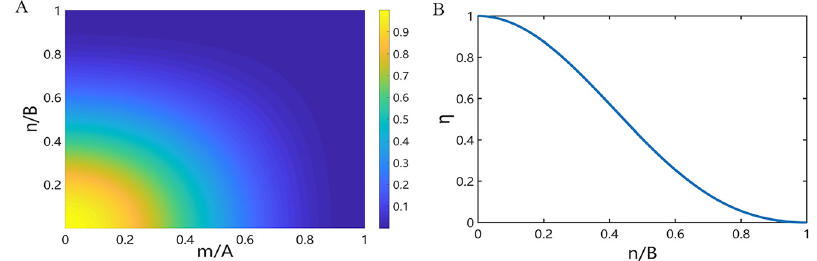
Figure 3: (A) The relationship between the highest achievable anomalous refraction efficiency and m / A , n / B when the incident light is diffracted to the ( m , n )th order. (B) The relationship between the highest achievable anomalous refraction ef fi ciency and n / B when the incident light is diffractedtothe(0, n )thorderandwhenthe metasurface has only one phase gradient along a single